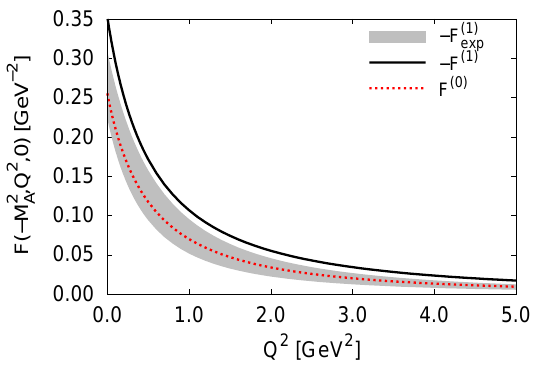
Figure 1. Behaviour of the form-factors for on mass-shell f 1 (1285). Nonlocal model calculation: black , Q 2 , 0), red dotted is F (0) solid line is − F (1) ( M 2 A AV γ ∗ γ ∗ , Q 2 , collaboration for − F (1) ( M 2 A AV γ ∗ γ ∗